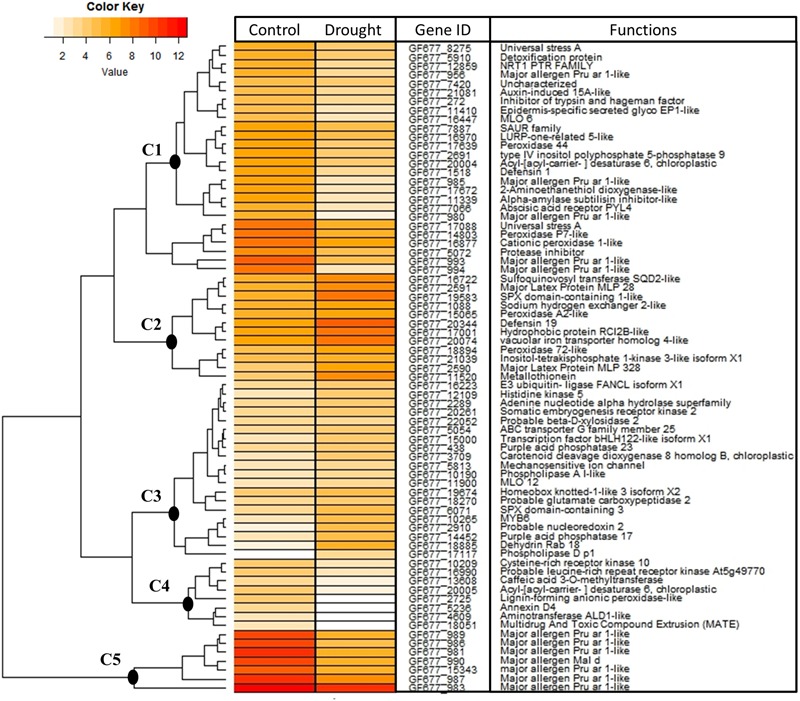
Heat map of the DEGs in roots (GF677 rootstock) that are involved in “response to stimulus” (GO: 0050896). The colors indicate the abundance of transcripts calculated as Log2 (RPKM+1) in the control and drought-stressed plants (see color key). The main gene clusters are numbered from C1 to C5. Further information about each gene is provided in Supplementary Table S2, listed, and grouped in clusters.